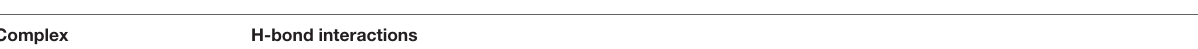
TABLE 1 | Potential H-bond interactions found in the proposed complexes.